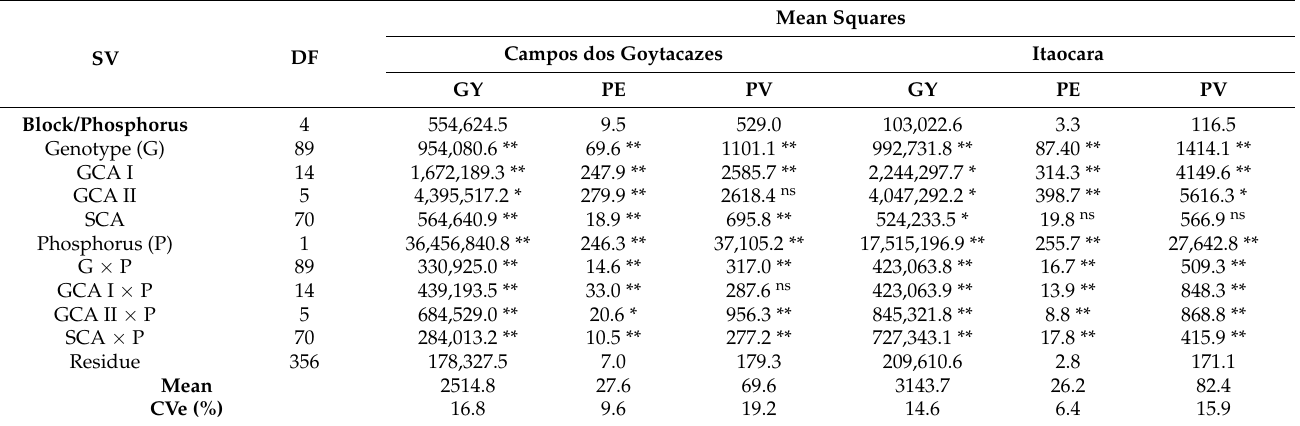
Table 1. Summary of the analysis of variance, of the general combining ability (GCA), and of the specific combining ability (SCA) for the agronomic traits evaluated in testcrosses under contrasting conditions of phosphorus in soil in Campos dos Goytacazes and